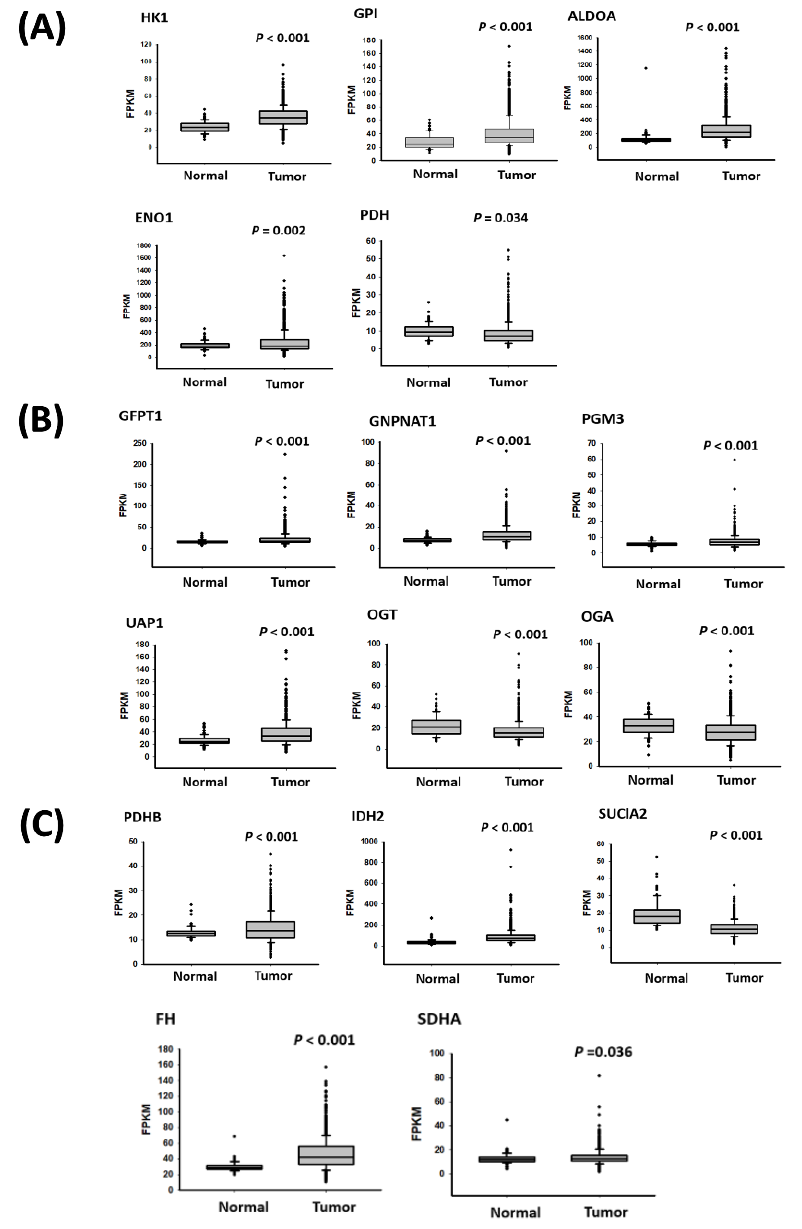
Figure 6. Expression levels of ( A ) glycolysis-associated enzymes, ( B ) HBP-related enzymes, and ( C ) TCA cycle-related enzymes were examined in breast cancer by analyzing data from the TCGA da- tabase.